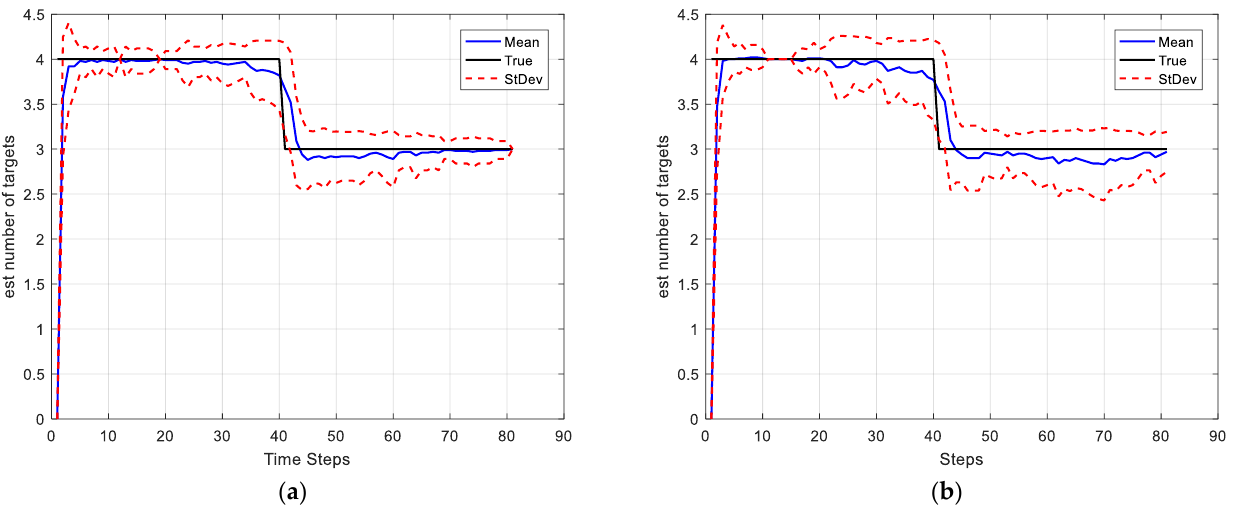
Figure 9. The standard deviation range value and the mean value of the estimated number of targets in the case of detection probability varying. ( a ) IGGM-PMBM filter, ( b ) BGM-PMBM filter.